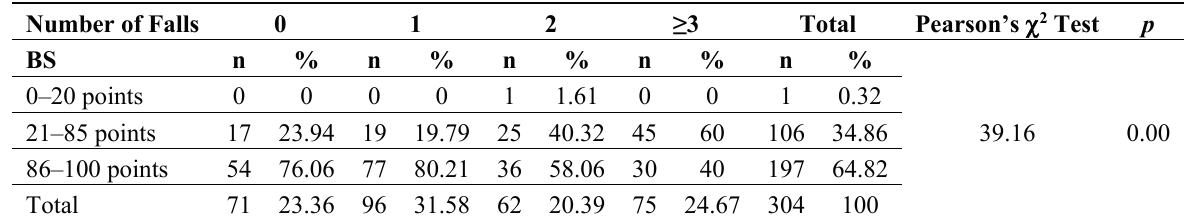
Table 3. The correlation between the number of falls and the results of the BS (Pearson’s correlation coefficient).